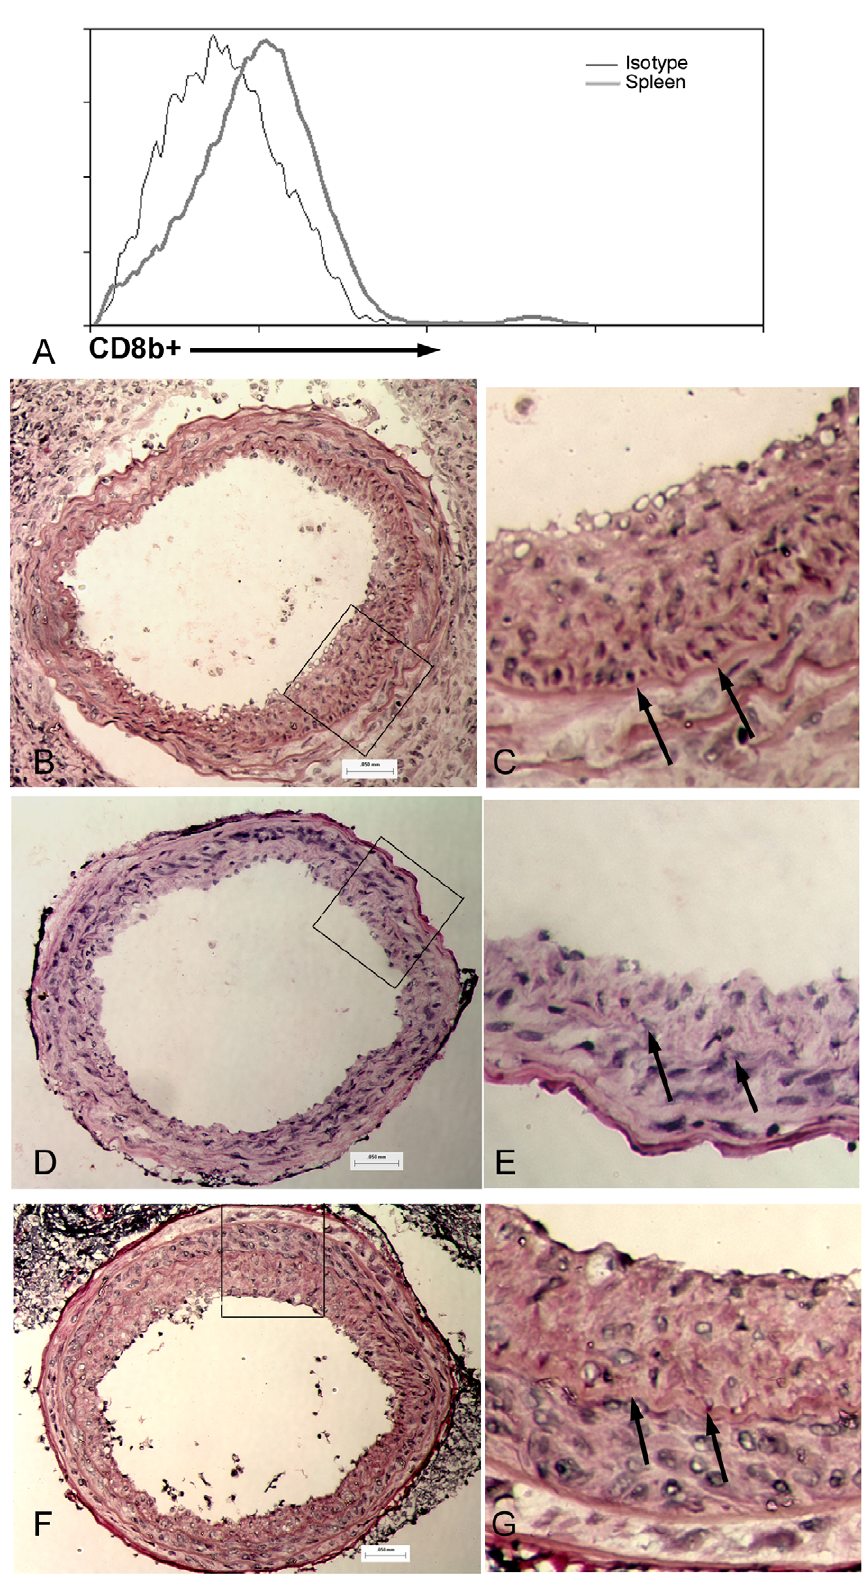
Figure 4. Adoptive T cell transfer. Representative histogram of CD8 + T cells homing-into the spleen of a recipient mouse 48 hours after cell transfer, before arterial injury (A). Viable lymphocytes were gated on the FSC/SSC plot. Representative sections of 21-day injured carotid arteries (400 6 magnification) stained with hematoxylin and eosin from Rag-1 2 / 2 mice (B), Rag-1 2 / 2 injected with CD8 + T cells (D), and Rag-1 2 / 2 mice injected with CD4 + T cells (F). Boxed area indicates magnification of the respective cross-sections (C, E, G). Arrows indicate internal elastic lamina. Bar=50 microns.